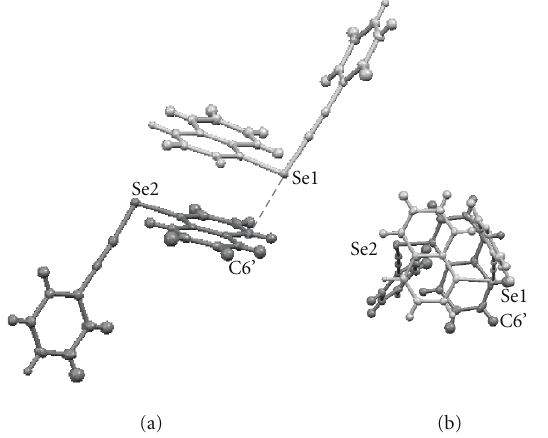
Figure 2: Dimer formed in 1a , which contains 1a A and 1a B : (a) a side view ( r (Se1—C6 (cid:6) ): 3.392 ˚A) and (b) a top view.